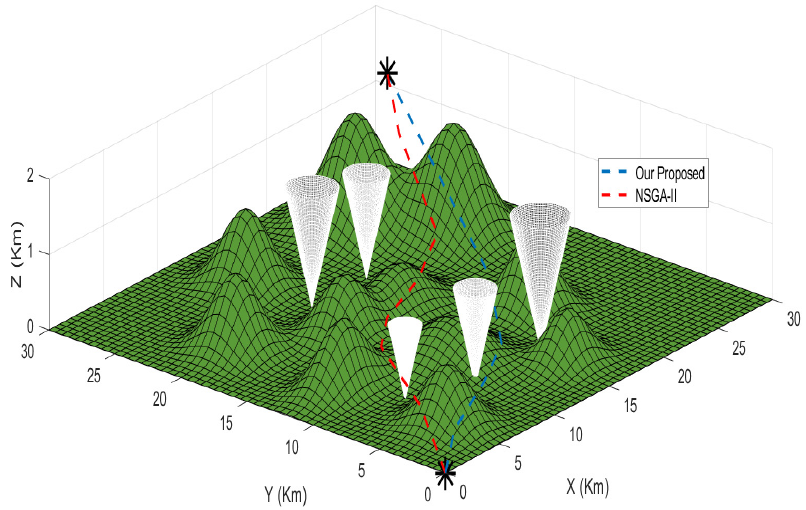
Figure 5. Comparison of the proposed algorithm with NSGA-II algorithm.